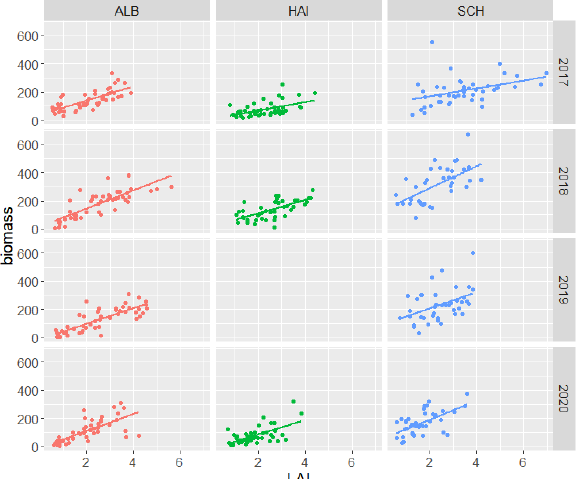
Figure 1: Grassland above ground biomass vs. Leaf Area Index (LAI) derived with PROSAIL from